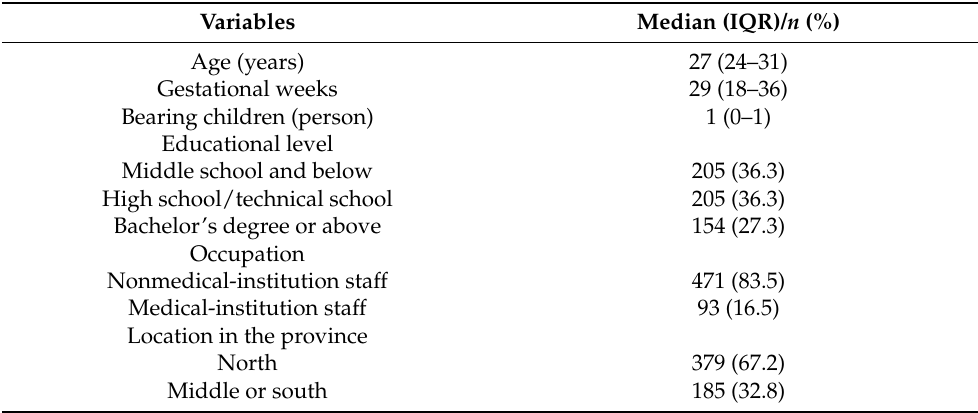
Table 1. Participant